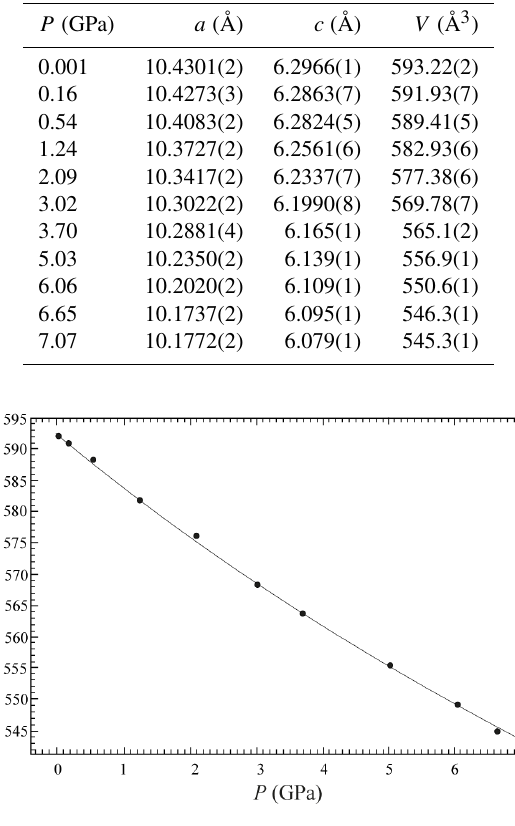
Table 4. Lattice parameters of burbankite at different pressures, col- lected using methanol:ethanol (4 : 1) as the P -transmitting medium ( P uncertainty ± 0.05GPa).